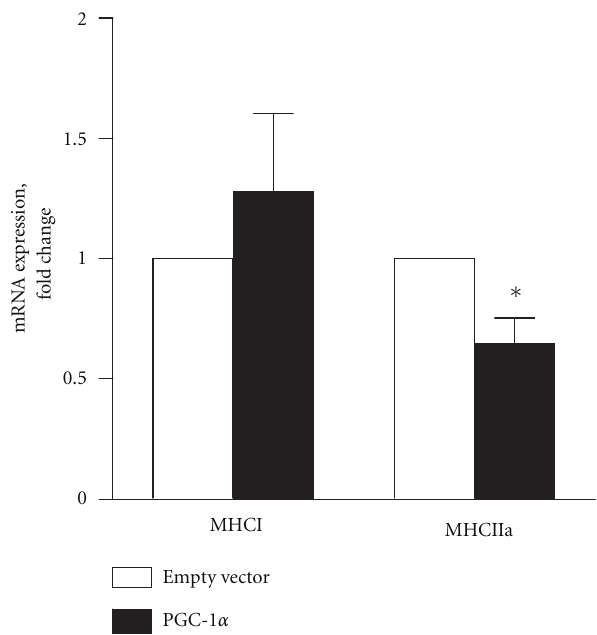
Figure 7: E ff ects of PGC-1 α overexpression on mRNA expression of fiber-type marker genes MHCI and MHCIIa. mRNA was isolated from cultured myotubes infected with either empty control vector or PGC-1 α , eight days after the onset of di ff erentiation. Gene expression was assessed by RT-PCR, and values are presented as means ± SEM of 3 experiments, each representing one donor, with 3 replicates each, normalized to the levels of housekeeping gene 36B4. ∗ Significantly di ff erent from cells infected with empty control vector at P < 0 .